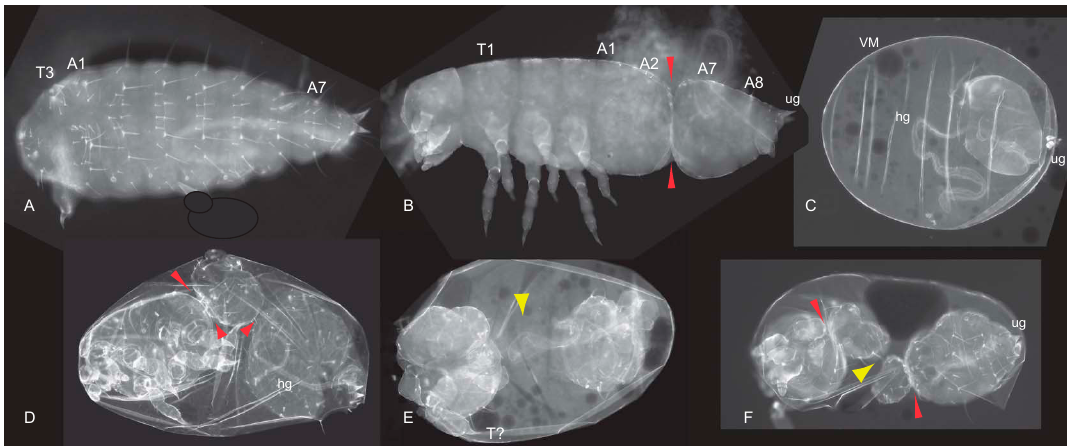
Figure 5. Tc-lrp4 is essential for patterning the anterior-posterior axis and for segmentation. ( A – F : Cuticle preparations). ( A ) Headless Tc-lrp4 RNAi larval cuticle. ( B ) Tc-lrp RNAi phenotype with a constricted abdomen (arrow heads) missing abdominal segments A3–A6 (“gap-phenotype”). ( C ) Remnant of the posterior cuticle including the urogomphi and the hindgut within the vitelline membrane. ( D , E ) Gap-phenotypes are characterized by constrictions and loss of body parts (shown by arrowheads). ( D ) Constrictions between thorax and abdomen and within the abdomen (arrowheads). ( E ) Larval cuticle consists of two pieces (yellow arrowhead indicates absence of connection). The anterior part developed with one pair of malformed legs of unknown identity (T?). ( F ) Cuticle consists of two pieces, each in addition shows constrictions (red arrowheads). Separation is indicated by the yellow arrowhead. A1: abdominal segment 1, HD: hindgut, Lb: labial segment; Mx: maxillar segment, T1: thoracic segment 1. ug: urogomphi. VM: vitelline membrane.